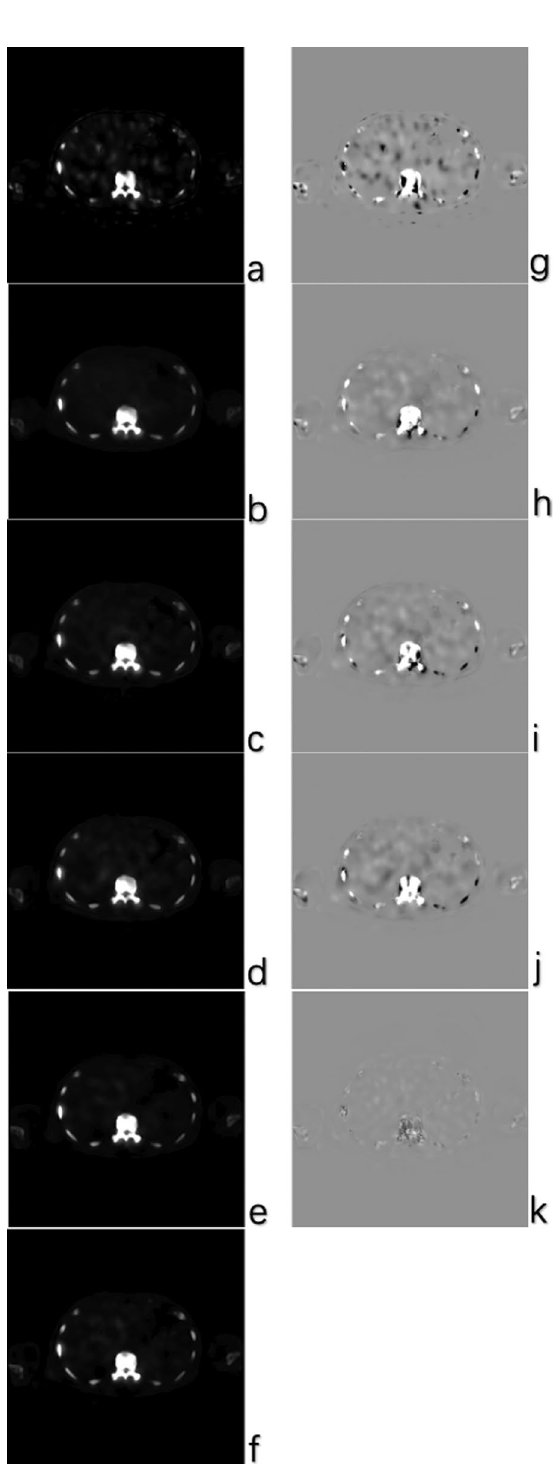
Fig. 6 Clinical assessment results of image quality for 1/7 SPECT, proposed method and the standard SPECT. The average scores for the 1/7 SPECT, proposed method and the standard SPECT are 2, 3.85 and 3.85 in terms of general image quality, 1.8,3.8 and 4.15 for details of contrast, 2, 3.75 and 3.9 for presence of artifacts and 1.95, 3.85 and 4.15 for diagnostic confidence. 1/7 SPECT is significantly different from SPECT image enhanced by proposed method under Wilcoxon test ( P < 0.05) for all evaluation metrics. Compared to the standard SPECT, proposed method achieved the same general image quality ( P > 0.999), similar detail of 99mTc‑MDP ( P 0.125), presence of artifacts ( P 0.531) and the diagnostic confidence ( P = = =